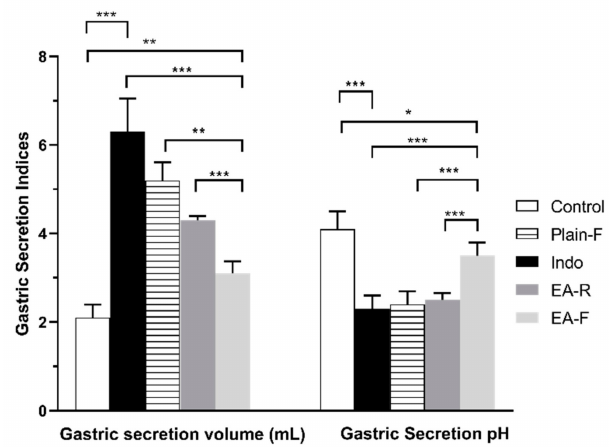
Figure 7. The e ff ect of indomethacin, raw EA, plain formula and optimized EA–Ca pectinate formula on gastric secretion volume (left section) and gastric secretion pH (right section). Data are presented as mean ± SEM. Significantly di ff erent at * p < 0.05, ** p < 0.01, *** p < 0.001. Indo: indomethacin, Plain-F: Plain formula, EA-R: pure ellagic acid, EA-F: ellagic acid